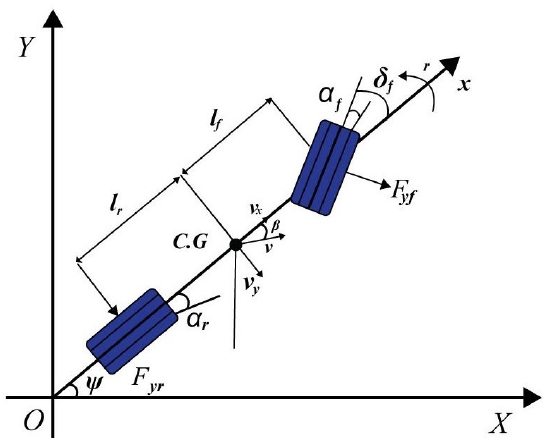
Figure 2. Vehicle dynamic bicycle